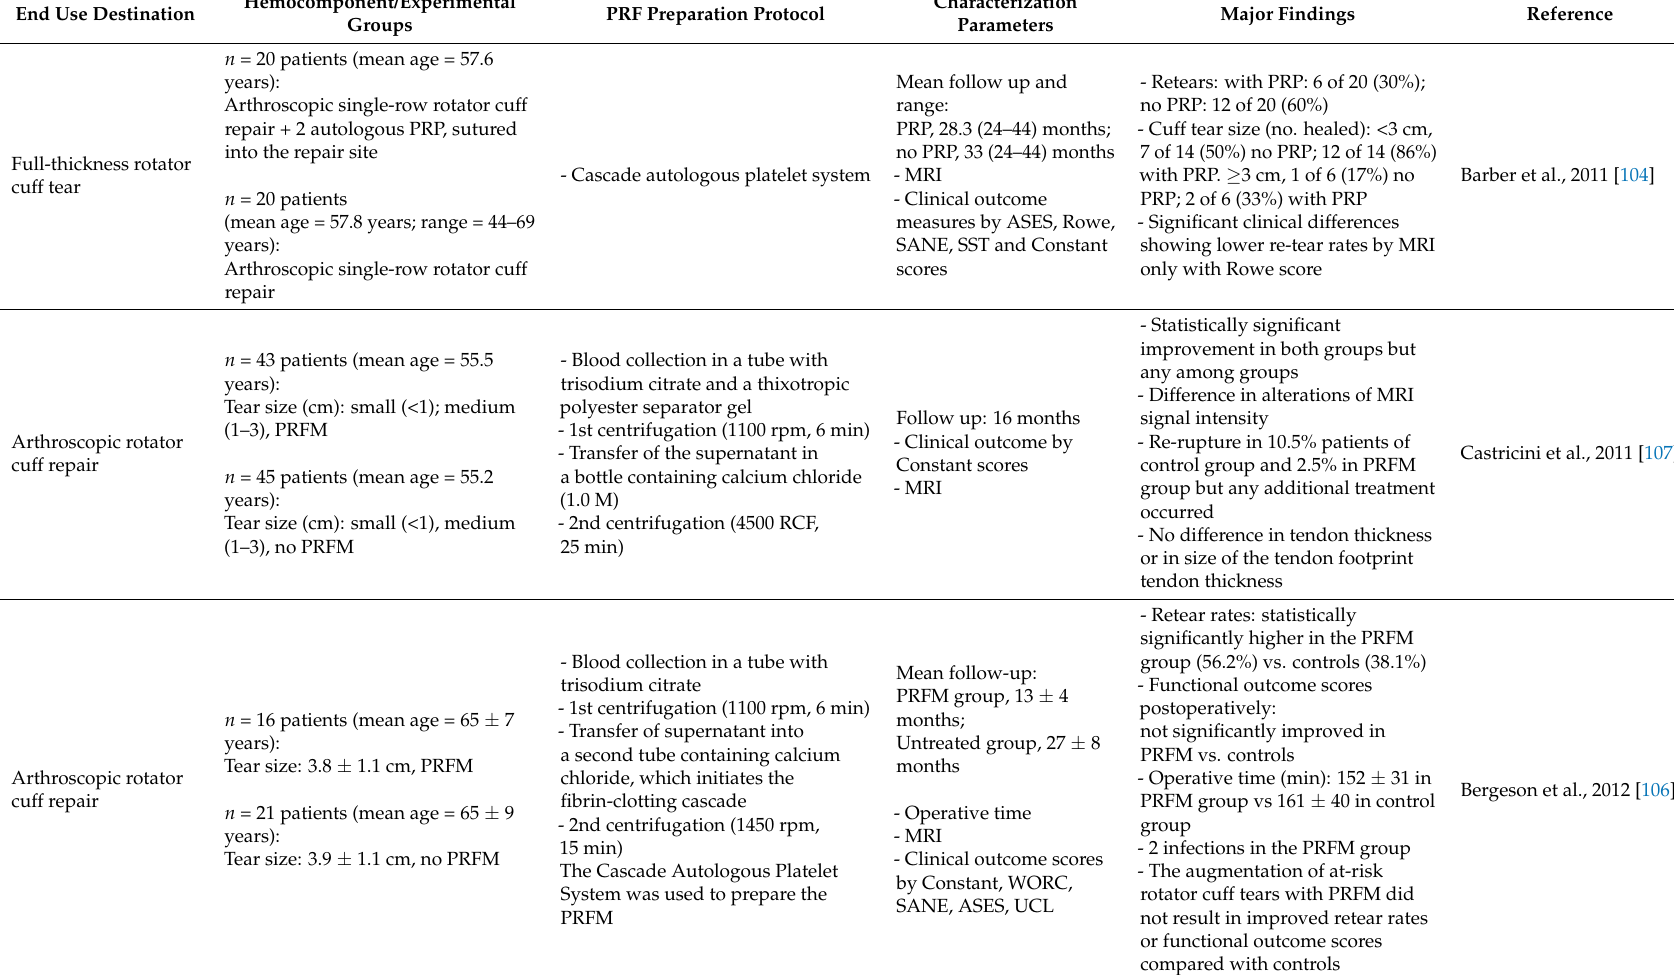
Table 6. Clinical trials on PRF derivatives for tendons